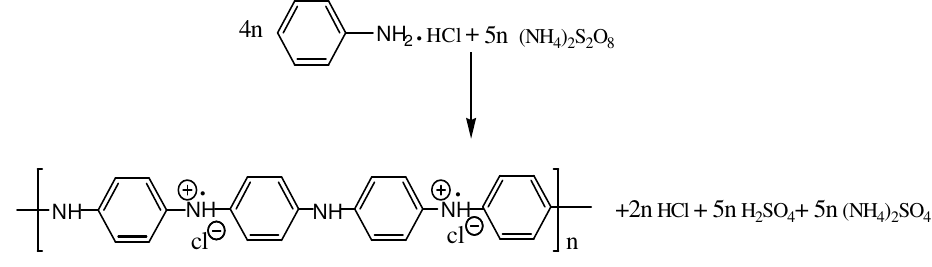
Figure 2. Overall polymerization reaction of PAn using ammonium